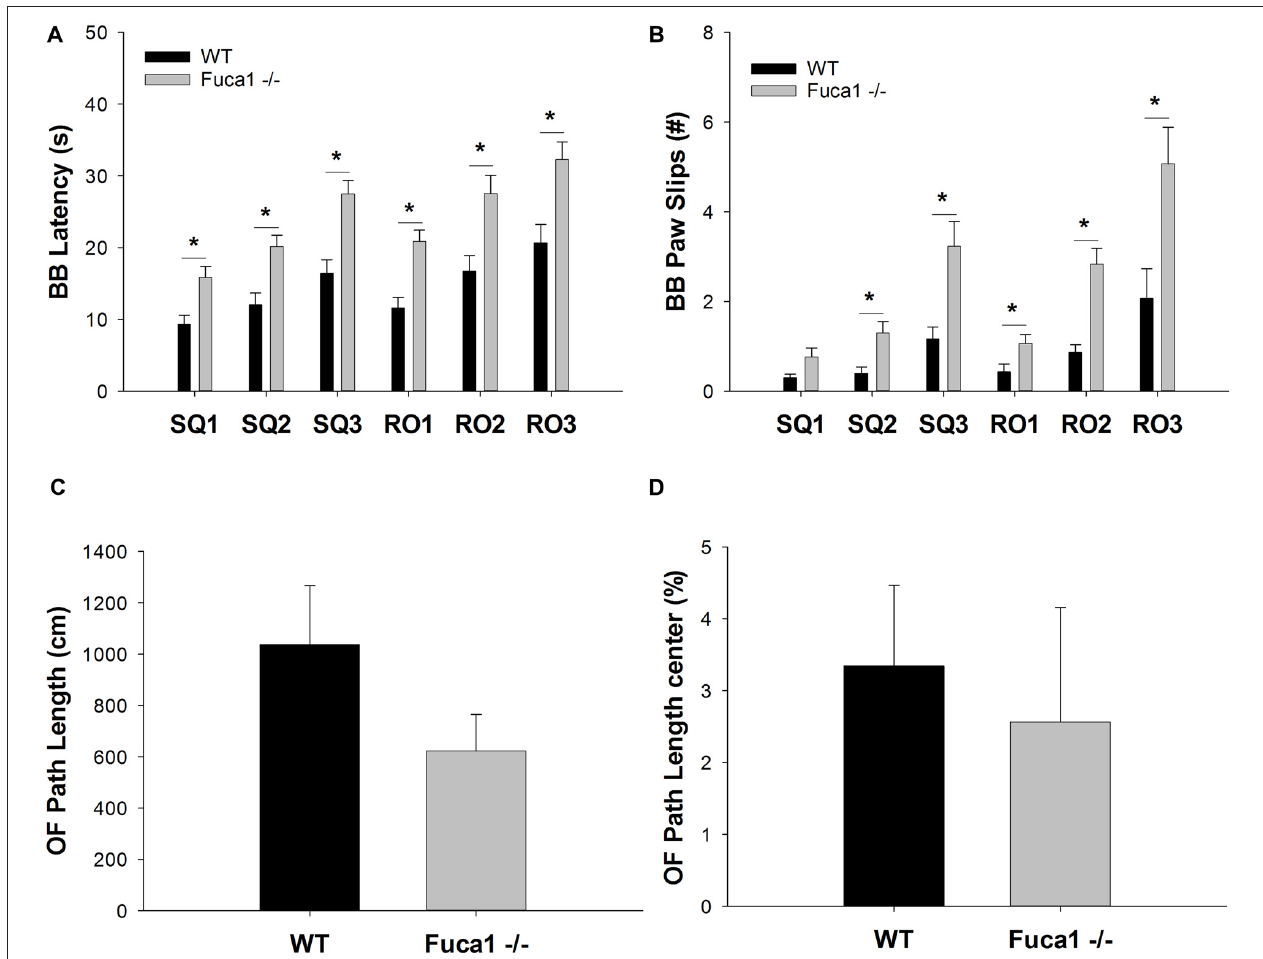
FIGURE 6 | Fuca1-deficient mice display impaired balance beam performance but no significant changes in open field behavior. (A,B) Balance beam performance in 3-month-old Fuca1-deficient mice (Fuca1 -/-, gray bars) and age-matched wildtype (WT) littermates (black bars). Fuca1-deficient mice were slower to traverse all square and round beam types in the balance beam test (A) . They also made significantly more paw slips in comparison to WT littermates on all beams except SQ1 (B) . (C,D) Open field behavior in 3-month-old Fuca1-deficient mice (Fuca1 -/-, gray bars) and age-matched WT littermates (WT, black bars). No significant changes were observed during open field exploration in 3-month-old Fuca1-deficient mice in comparison to WT animals, as illustrated by total path length (C) and the relative distance traveled in the center of the arena (D) . All data are presented as mean ± standard error of the mean (SEM; both genotypes n = 15). Abbreviations: BB, balance beam; SQ, square; RO, round; OF, open field. Asterisk indicates significance of difference.